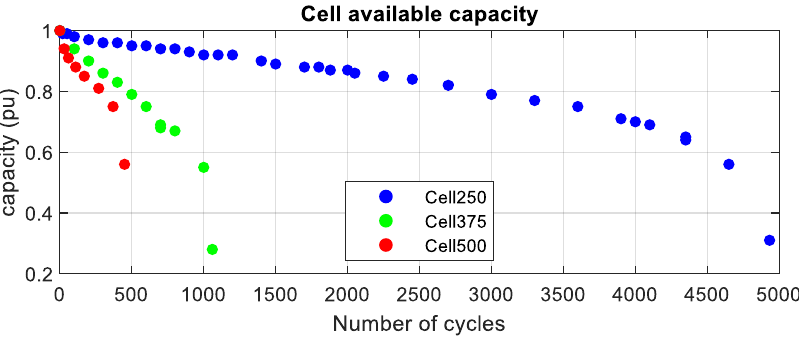
Figure 4. Cell capacity as a function of the number of cycles performed.